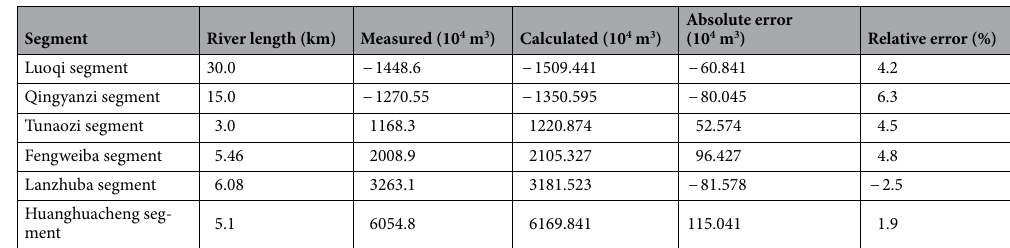
Table 6. Verification of the sedimentation volume in typical reaches of the trunk stream in the TGR area from 2008 to 2017 (based on the cross-section).